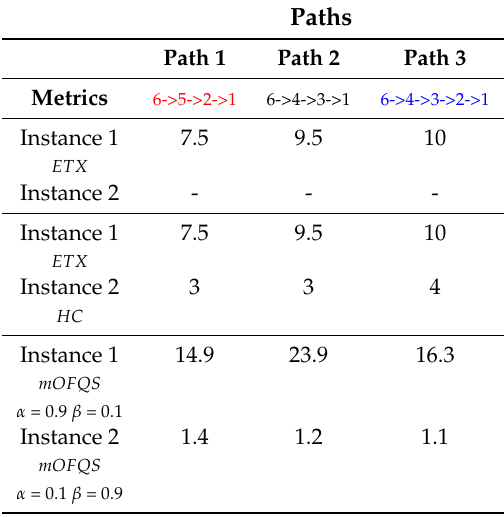
Table 2. Paths values for the different metrics